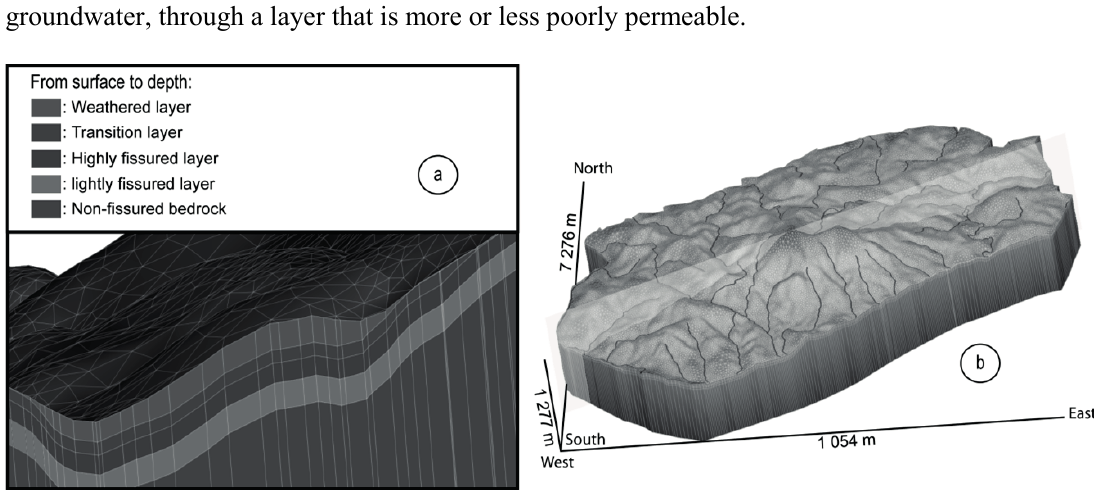
Fig. 2 Geometry of the numerical model (a factor of 2 is applied to the vertical